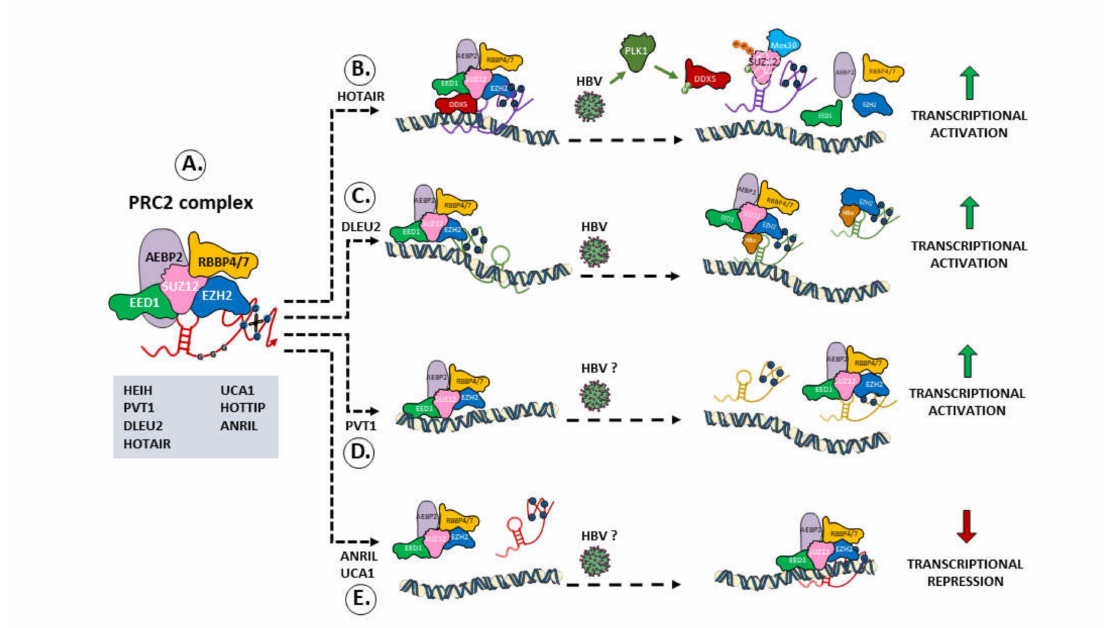
Figure 2. LncRNAs/PRC2 interactome in HBV-related HCCs. ( A ) Schematic representation of the PRC2 complex and its interaction with lncRNAs. The PRC2 complex proteins EED1, SUZ12, and EZH2 have a high affinity to G-quadruplex sequences, an intermediate affinity to unstructured G-rich RNA, and a lower affinity to stem-loop RNA structures on lncRNAs. The lncRNAs deregulated in HBV-related HCCs that bind the PRC2 complex are listed in ( A ). In ( B ) to ( E ) are shown the functional consequences of their interaction and HBV infection on the activity of the PRC2 complex. ( B ) The lncRNA HOTAIR interacts with the PRC2 complex and the RNA helicase DDX5. HBV infection promotes the activation of PLK1, which phosphorylates SUZ12 [36] and DDX5 [37]. The downregulation of DDX5 in HBV-infected cells and in HBV-related HCCs allows the preferential association of HOTAIR with the E3-ligase Mex3b, the ubiquitination of SUZ12 and its proteasomal degradation [37]. The functional significance of the phosphorylation of DDX5 by PLK1 remains to be determined but the transcriptional repression exerted by the DDX5/PRC2/HOTAIR complex is impaired, leading to the transcriptional activation of PRC2/HOTAIR target genes, including EpCAM and other genes related to the hepatic progenitor cells (HPCs) phenotype. ( C ) The lncRNA DLEU2, activated by HBV infection and upregulated in HCC, directly binds HBx and EZH2 [34]. By increasing DLEU2 levels and by binding to DLEU2, HBx interferes with EZH2/PRC2 repressive functions and activates transcription. HBx interaction with DLEU2 either evicts EZH2, a modality prevalent on cccDNA, or displaces the PRC2/EZH2 complex from close contact with chromatin in the case of host genes. PCR2 subunits are still immunoprecipitated with their target chromatin sequences [34]. The precise mechanisms underlying the removal of the repressive H3K27me3 mark imposed by the PRC2 complex, the deposition of active H3K27Ac marks, and the conversion of PRC2 complexes to transcriptional activation are still unclear. ( D ) The upregulation of the lncRNA PVT1 in HBV-related HCCs and its interaction with the PRC2 leads to a loss of EZH2 recruitment to the c-Myc oncogene promoter and the concomitant reduction of the H3K27me3 mark. Interestingly, this leads to cell proliferation and the acquisition of stem cell-like properties [51]. ( E ) The lncRNAs ANRIL and UCA1, both upregulated in HBV-related HCCs, guide PRC2 to the Kruppel-like factor 2 (KLF2) [52] and the P27/Kip1 [39] promoters, leading to an increase of H3K27 tri-methylation and their transcriptional